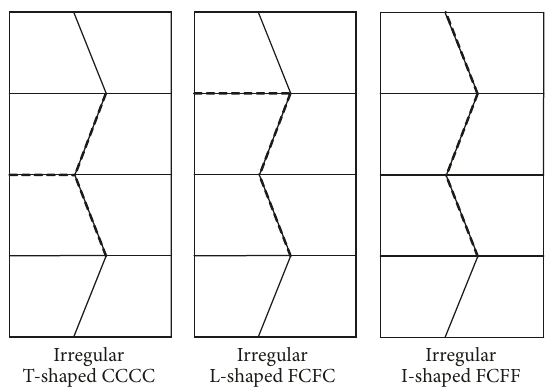
Figure 11: Geometries of three types of irregular cracks in a rectangular plate and the boundary